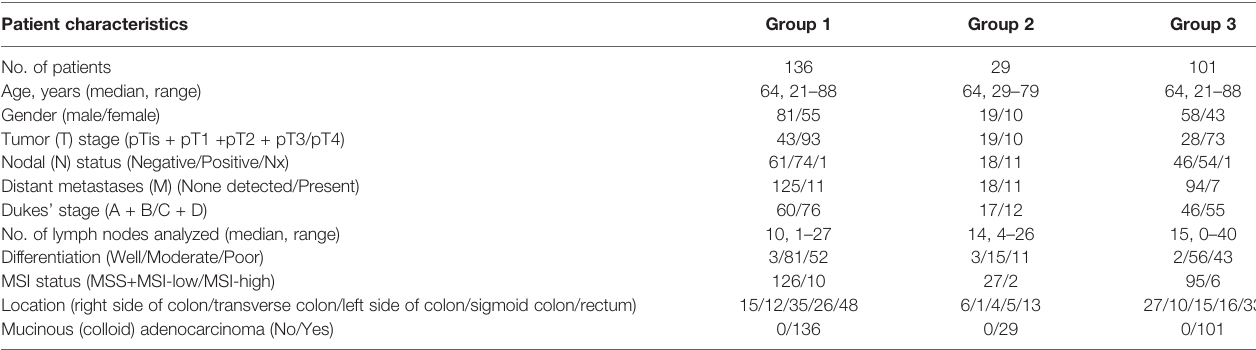
TABLE 3 | Characteristics of Patients.